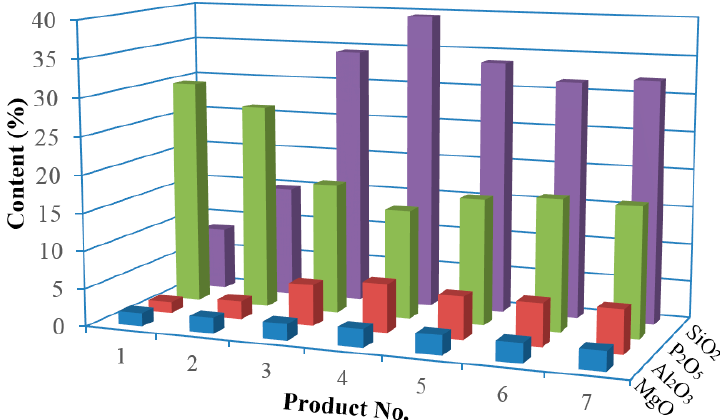
Figure 7. Chemical compositions of the products from spiral separation.